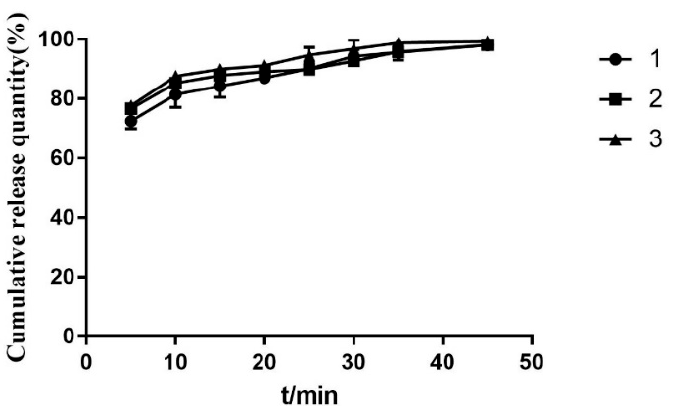
Figure 14. Dissolution curves of three batches of PCE solid dispersions.